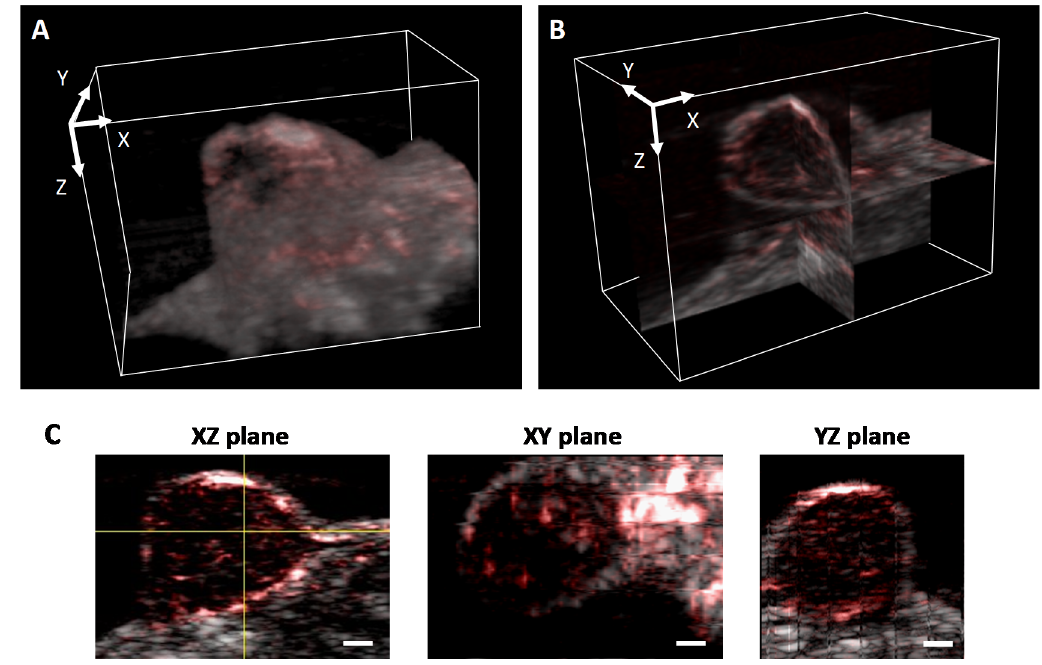
Figure 6. ( A ) Overlay of ultrasound and photoacoustic images of tumors reconstructed in 3D (Video 2) and ( B ) in orthoslice view. ( C ) Tumor images displayed in different 2D planes. (Scale bar = 2 mm, Video S2, MOV, 779 kB).